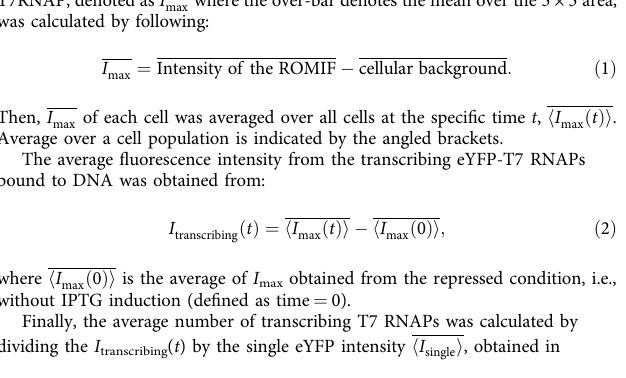
Supplementary Fig. 1. Detailed process of how h I single i was obtained is described in the next section. Quanti fi cation of fl uorescence intensity of a single eYFP . We constructed a strain expressing membrane-bound Tsr-eYFP (NL003) 32 and quanti fi ed